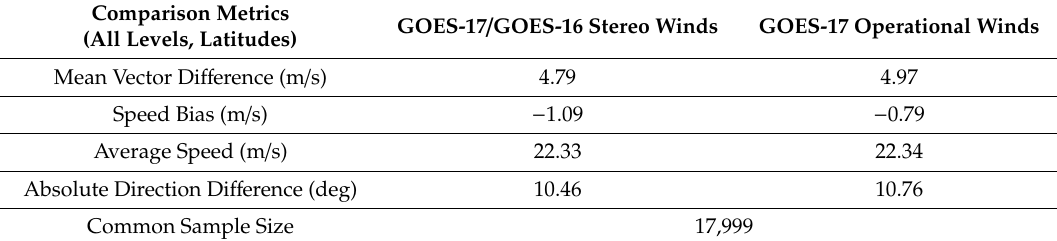
Table 3. Comparison statistics between rawinsonde winds (0 Z, 12 Z) and GOES-17 / GOES-16 stereo winds and National Oceanic and Atmospheric Administration (NOAA) operational GOES-17